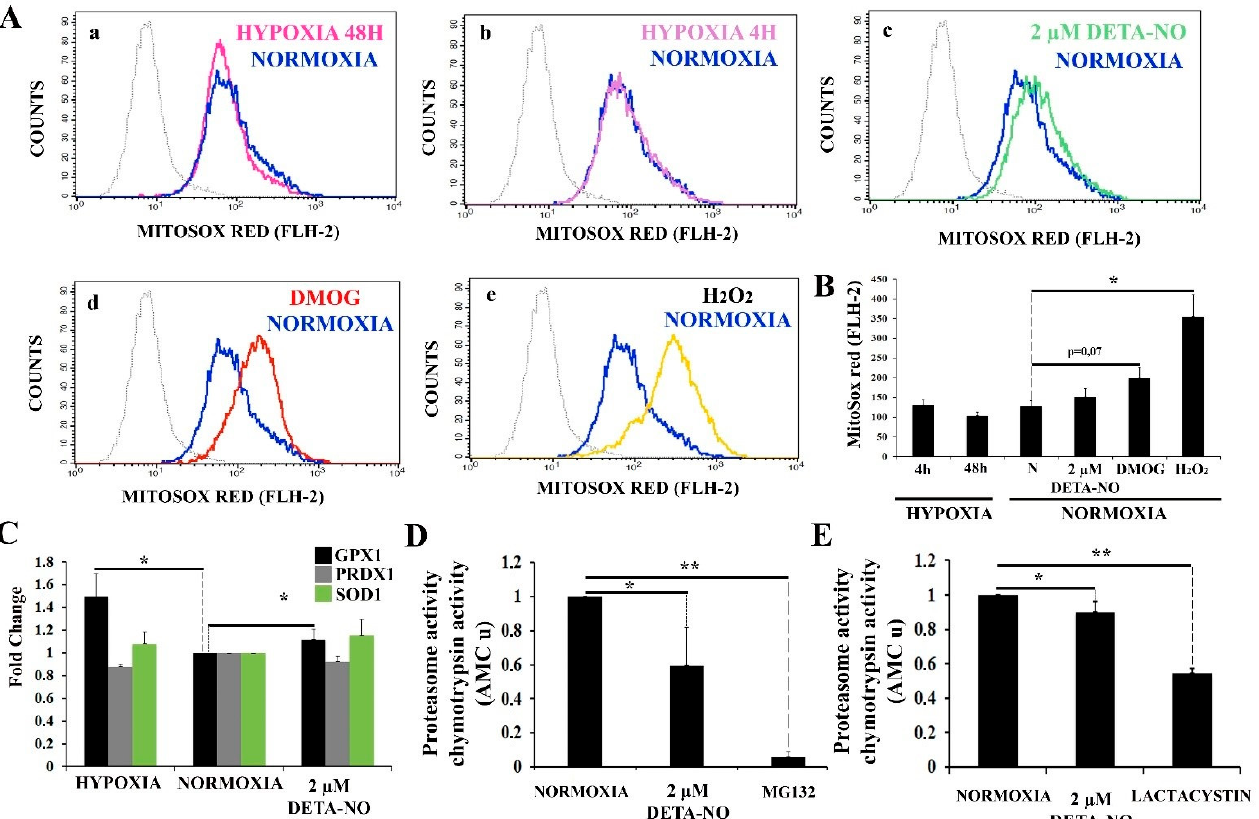
Figure 8. Treatment with low doses of nitric oxide donor maintains stable levels of mROS. ( A ) Measurement of O 2 − levels with MitoSox red. Human iPSCs were cultured for 6 days and then exposed to either hypoxia or normoxia for 4 and 48 h. A different set of cells were exposed to 2 µM DETA-NO under normoxia for 48 h. Finally, another set of cells were exposed to DMOG (1 mM) for 4 h under normoxia. To induce a high O 2 − production, cells cultured in normoxia were exposed to 200 µM H 2 O 2 for 1 h. Cytometry plots represent cells counted versus red fluorescence emitted in the different treatments (a) hypoxia 48 h, (b) Hypoxia 4 h, (c) DETA-NO, (d) DMOG, and (e) H 2 O 2 against the normoxia control. ( B ) The bar graph represents the mean intensity fluorescence ± SEM from 3 independent experiments. N, normoxia. (*) p < 0.005. ( C ) Analysis of the expression at the level of mRNA of antioxidant enzymes GPX1 (glutathione peroxidase 1), PRDX1 (peroxiredoxin 1), and SOD1 (superoxide dismutase 1) following exposure to hypoxia or 2 µM DETA-NO under normoxia for 48 h. The graph shows the mean of the relative expression of 5 independent experiments ± SEM. The relative expression was calcu- lated with the algorithm ∆∆ Ct. Values were relativized to the β -actin mRNA expression level and normoxia sample. (*) p < 0.05. ( D ) Proteasome activity in MSUH-001 cells. 20S proteasome activity was measured by analyzing chymotrypsin-like activity in cell lysates. Cells were cultured for 6 days in a conditioned medium supplemented with bFGF and in the pres- ence or absence of 2 µM DETA-NO for 48 h. MG132 (10 µM) was added to cell extracts to inhibit proteasome activity. Bars